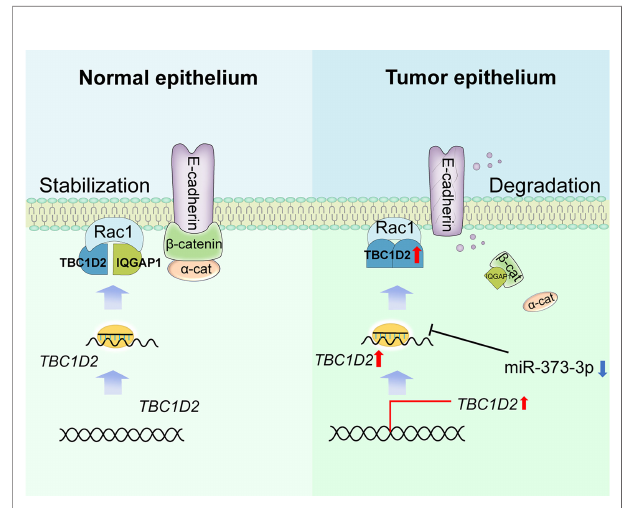
FIGURE 7 | Summary of study. Schematic depicting the underlying mechanisms through which TBC1D2, negative regulated by miR-373-3p, promotes ovarian cancer metastasis via E-cadherin degradation induced by disintegration of Rac1-IQGAP1